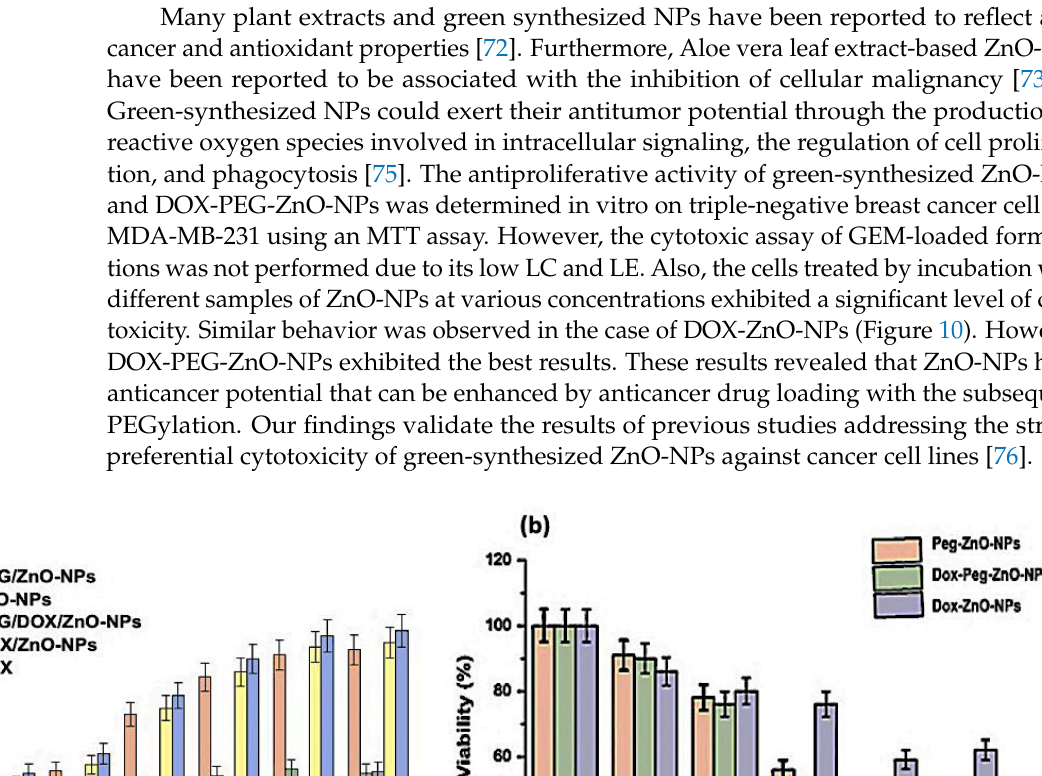
Figure 11. DOX/PEG-ZnO-NPs sample of metal oxide % cell viability and IC 50(6.3 µg/mL) analysis with a concentration range of 0–200 µg/mL 4. Conclusions The biogenic green synthesis process was employed to generate ZnO-NPs using Aloe vera plant extract as a stabilizing and capping agent in the medium. The optimum reaction conditions, easy and cost-effective procedures, and medicinal applications of the green synthesis ZnO-NPs-based drug delivery system are highlighted in our research findings. Literary contributions in the field of medical oncology for effective clinical cancer therapy were also studied. The synthesized ZnO-NPs had particle sizes in the range of 20–40 nm, which is considered ideal for the investigated drug carrier system. The DOX had better loading capacity and loading efficiency than GEM against PEGylated and non-PEGylated ZnO-NPs. Therefore, the DOX-loaded nanoparticles (PEGylated and non-PEGylated), along with the untreated ZnO-NPs, were shortlisted for in vitro analysis, which exhibited potent cytotoxicity against the investigated breast cancer. The antiproliferative activity of DOX/PEG-ZnO-NPs was determined in vitro on triple-negative breast cancer cell line MDA-MB-231 using the MTT assay. On the other hand, the cytotoxic assay of GEM- loaded formulations was not performed due to the its low loading capacity and loading efficiency. Cells incubated with ZnO-NPs at various concentrations exhibited a significant